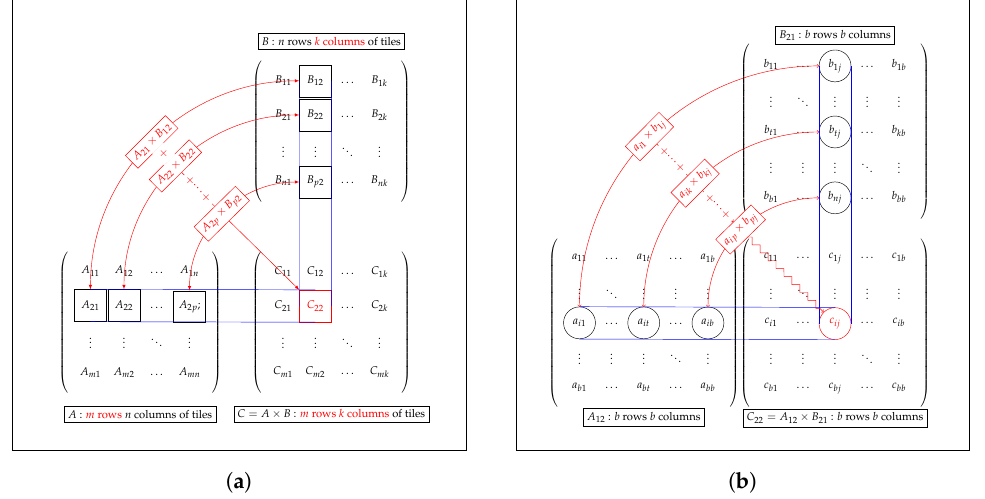
Figure 4. Structure of matrix multiplication. ( a ) Matrix-matrix multiplication; ( b ) tile-tile